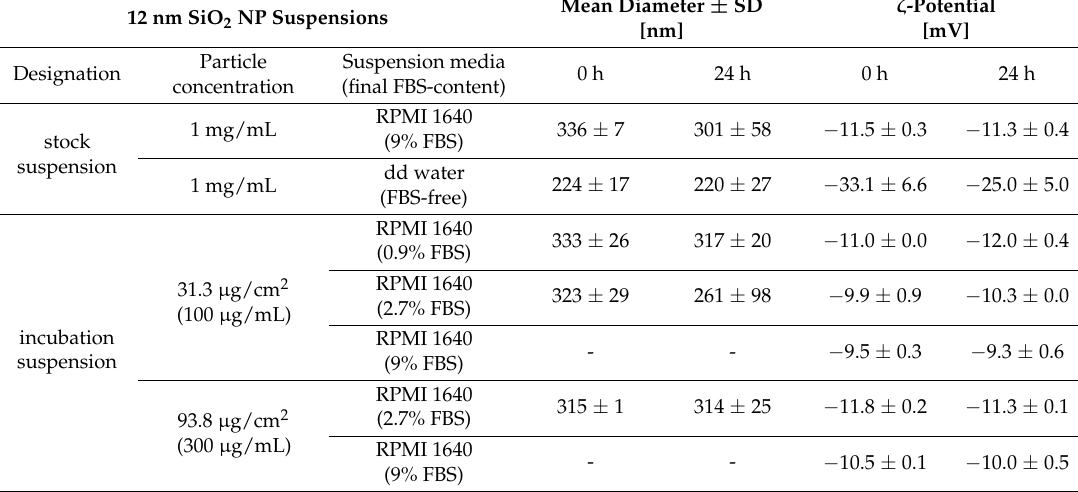
Table 1. Mean diameters ± standard deviations (SD) measured by nanoparticle tracking analysis and ζ -potentials of various 12 nm SiO 2 particle suspension preparations comprising different amounts of fetal bovine serum (FBS) analyzed shortly after sample preparation (0 h) and after 24 h of